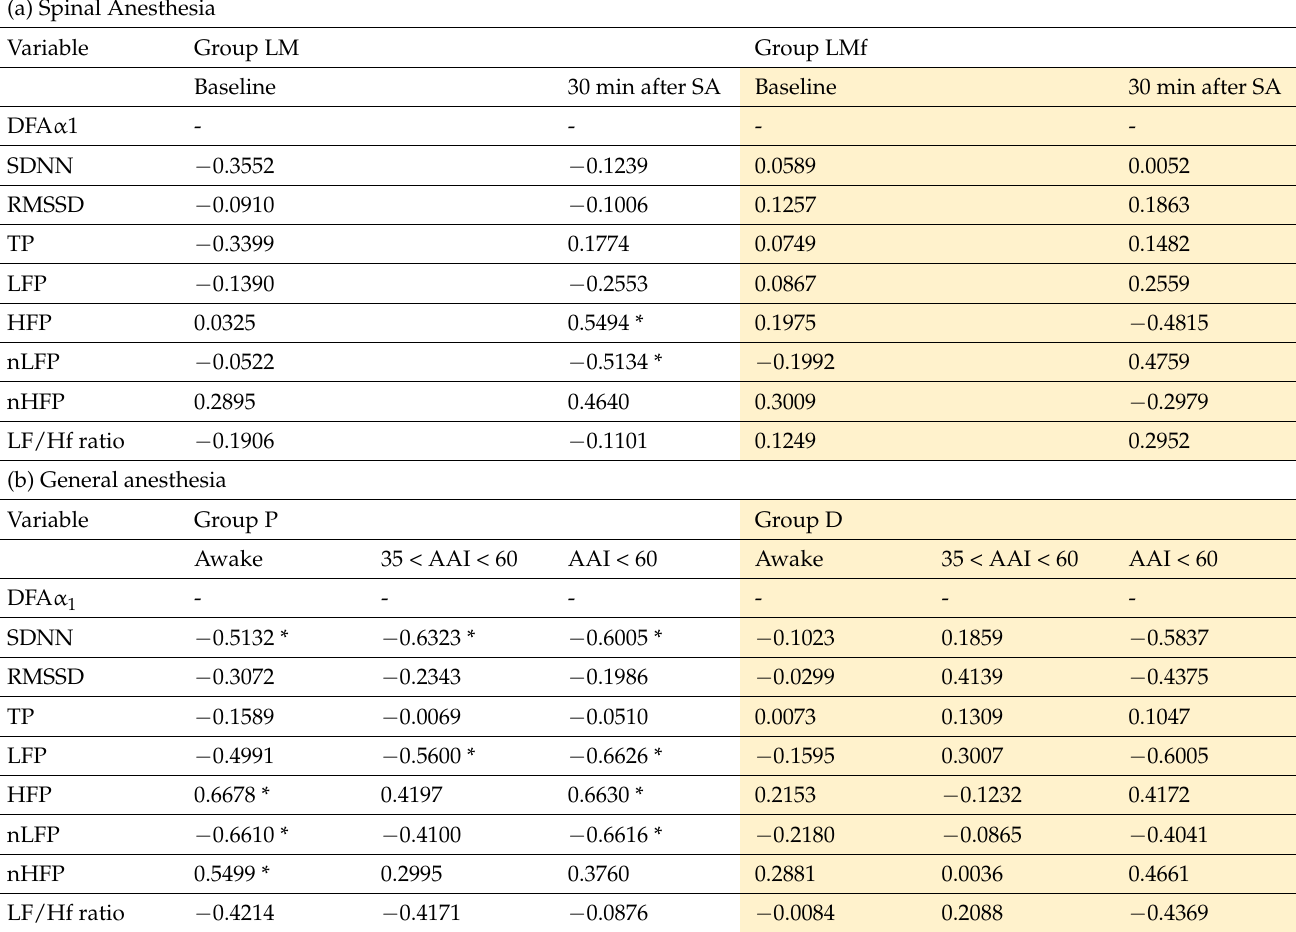
Table 3. Correlation coefficient between traditional measures and DFA α 1 after spinal (a) and general anesthesia for all groups